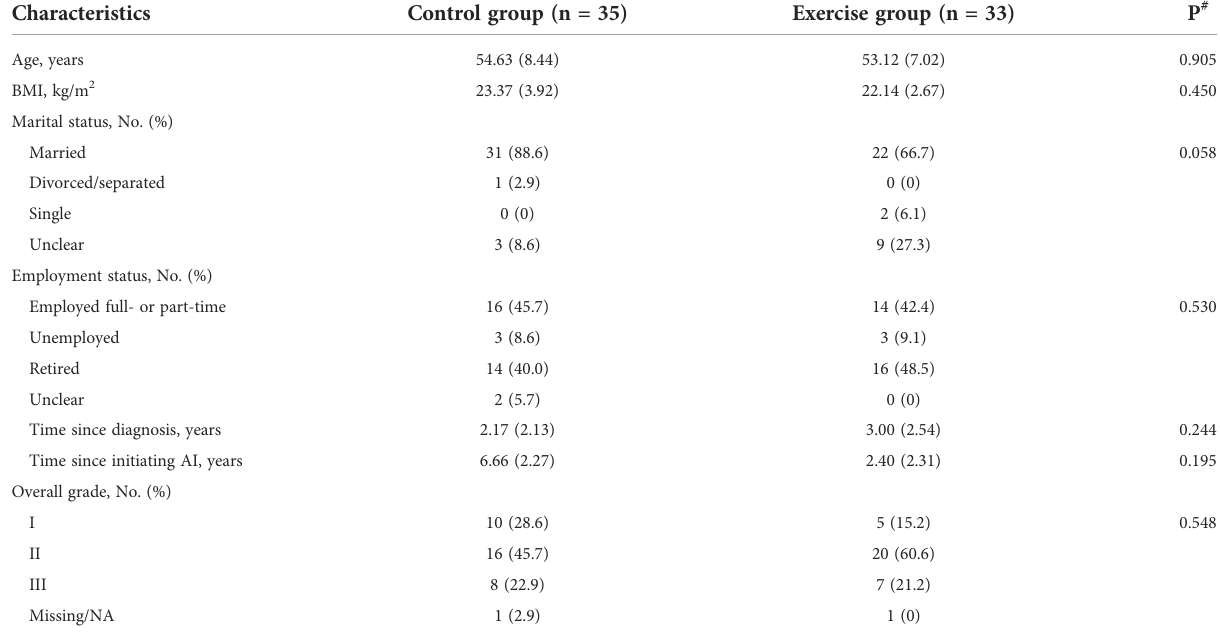
TABLE 1 Baseline characteristics of patients*.